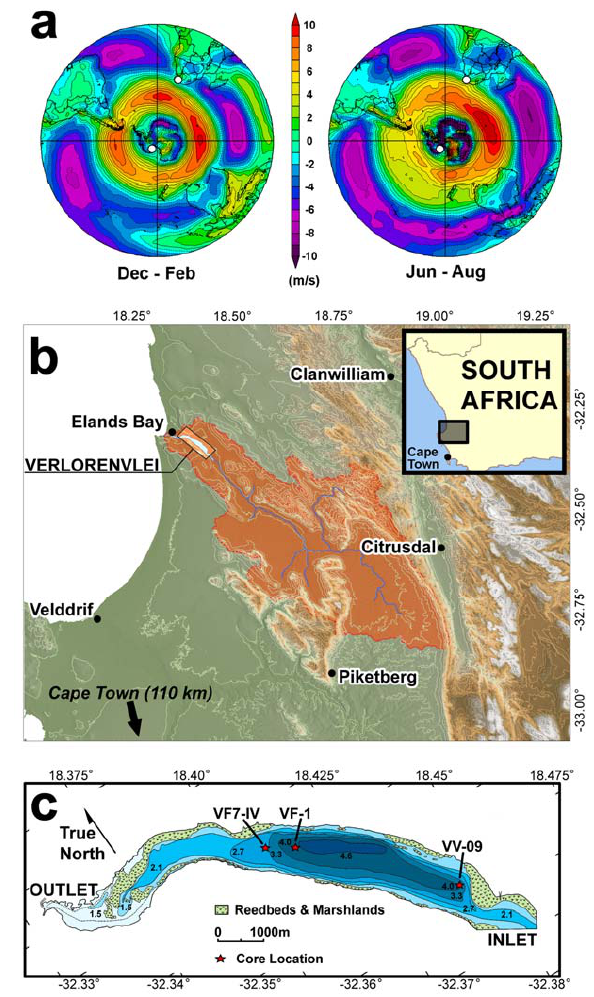
Fig. 1. Location maps. (a) Seasonal variations in the extent and speed of the austral westerlies, with Verlorenvlei and Siple Dome indicated (white dots). (b) Verlorenvlei watershed, with location in South Africa (insert). (c) Verlorenvlei bathymetry with coring sites indicated